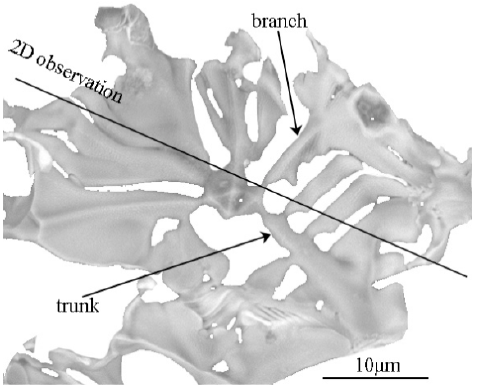
Figure 9. Schematic diagram of the difference between the 2D and the 3D observations.